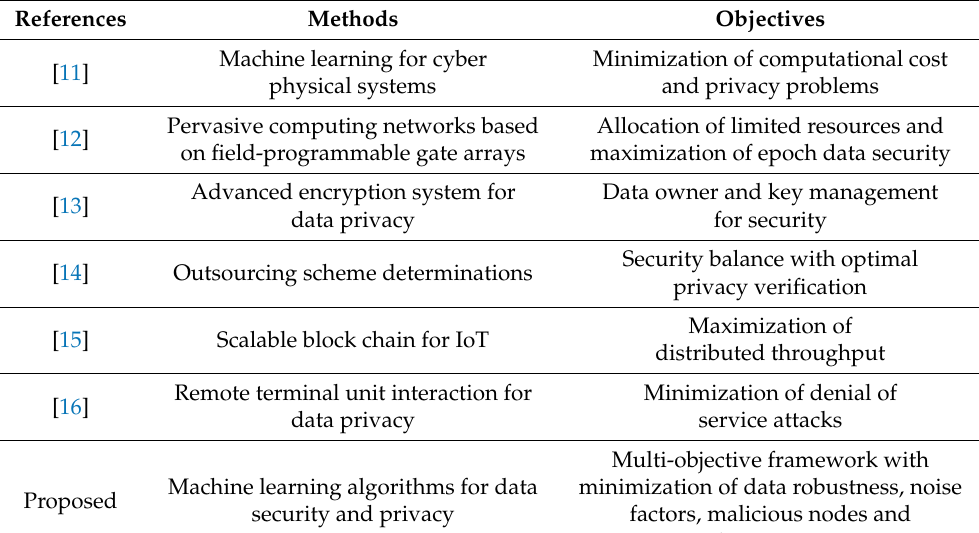
Table 1. Comparison of relevant